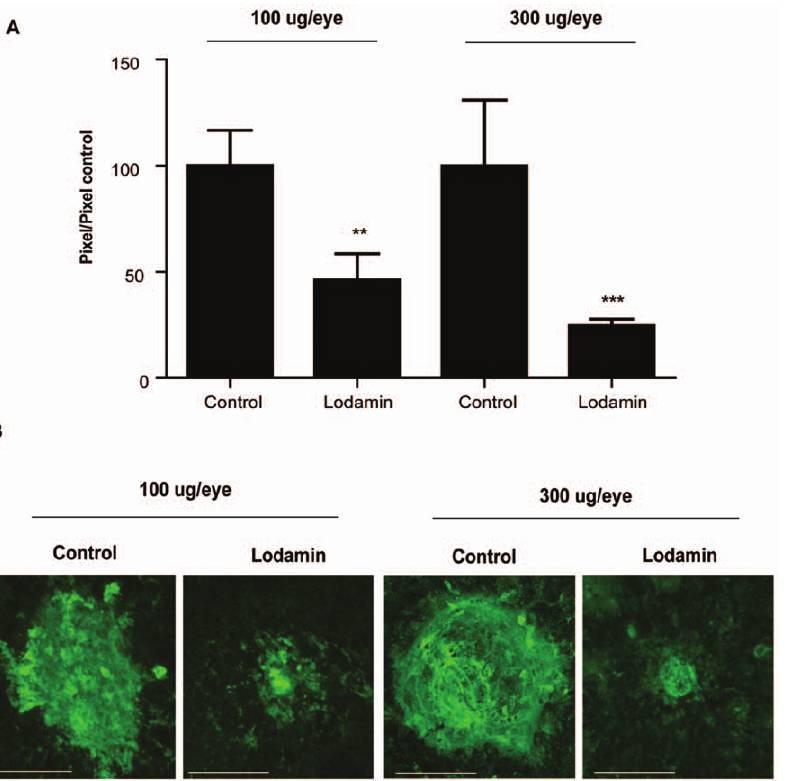
Figure 4. Lodamin injected intravitreal suppresses CNV progression. ( A ) CNV lesions were induced by a diode pumped solid state laser around the optic nerve through a slit lamp delivery system. Only lesions in which a subretinal bubble or focal serous detachment of the retina developed were used for the experiments. Four burns were performed per eye while leaving a space around the optic disc. At the day of laser induction intravitreal injection of Lodamin was performed. Size of CNV lesions after intravitreal injections of Lodamin: 100 m g Lodamin per eye (12.5 m g TNP-470 equivalent) or 300 m g Lodamin per eye. Data is presented as mean pixel number 6 SEM (n=7–17, *P , 0.05, U-test). ( B ) Representative images of retinal flat-mounts stained with a lectin-FITC, Bars=10 m m.